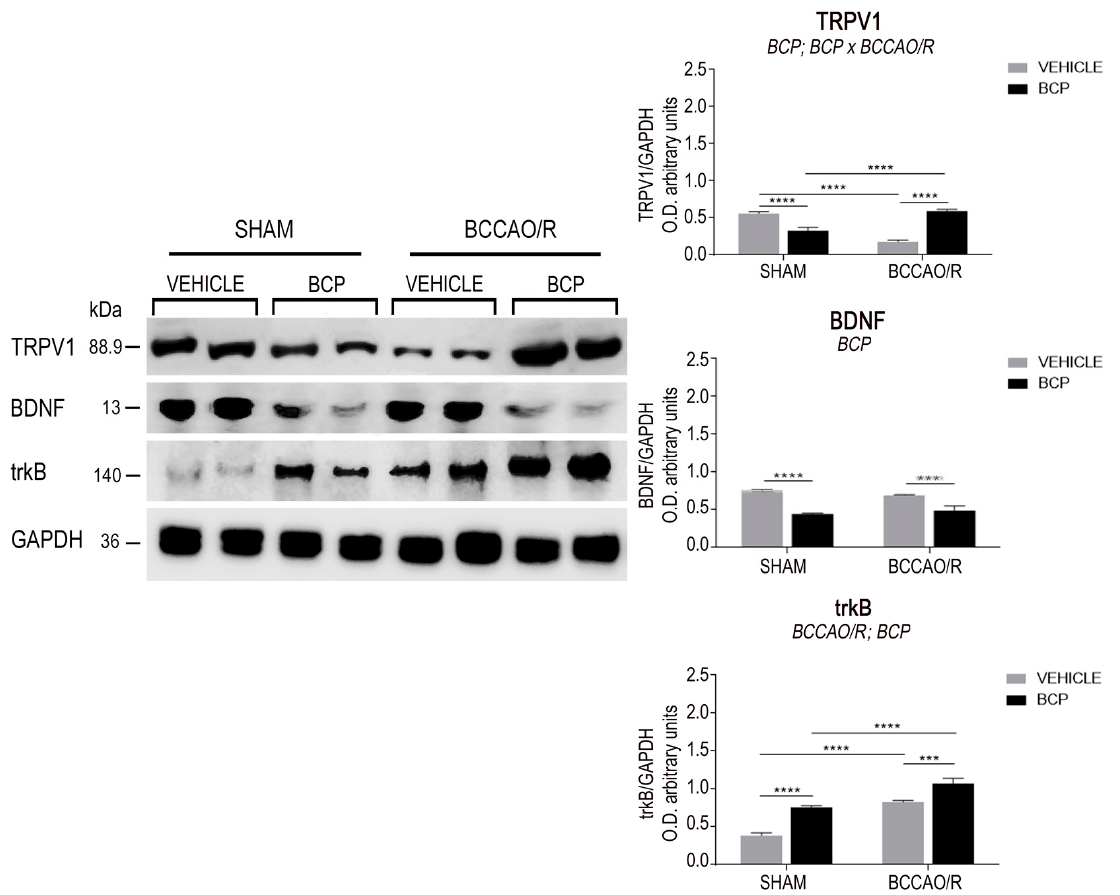
Figure 1. Western blot analysis of the frontal cortex homogenates in vehicle-treated and beta- caryophyllene (BCP)-treated rats either in sham-operated or after bilateral common carotid artery occlusion followed by reperfusion (BCCAO/R). ( Left ) Transient receptor potential vanilloid type- 1 receptor (TRPV1), brain-derived neurotrophic factor (BDNF), tyrosine kinase receptor B (trkB), glyceraldehyde-3-phosphate dehydrogenase (GAPDH) proteins. ( Right ) Densitometric analysis of the band gray levels expressed as a percentage of the optical density (O.D.) ratio of TRPV1-, BDNF-, trkB-positive bands to those immunostained for GAPDH. Data are reported as the mean values